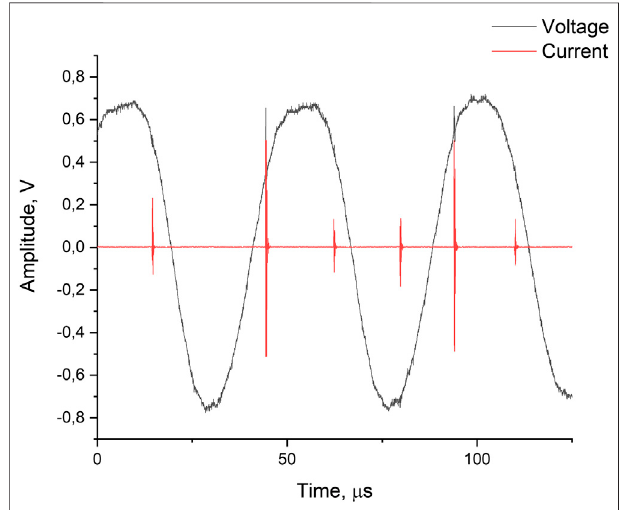
FIGURE 4 | Graph of current and voltage over time